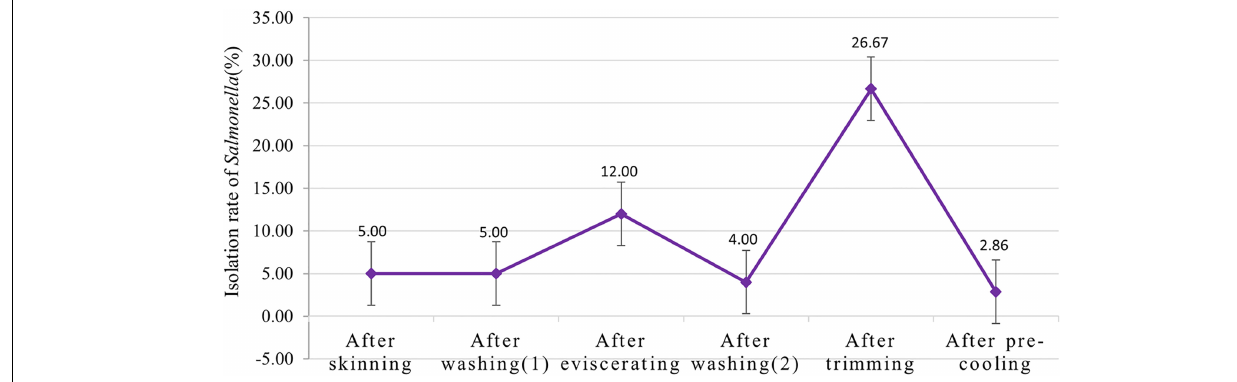
FIGURE 5 | Isolation rate of Salmonella in different slaughtering processes.